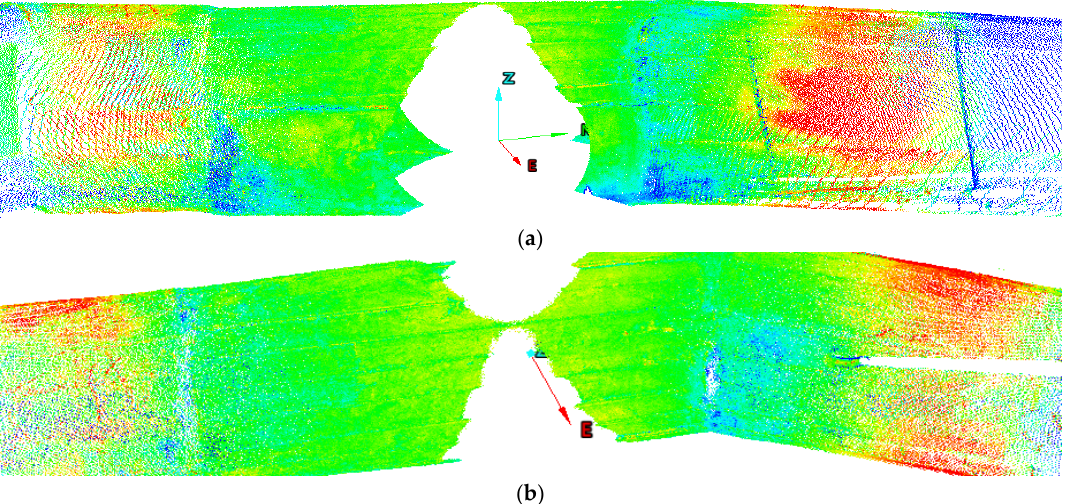
Figure 13. Missing 3D laser point cloud data. ( a ) Side view; ( b ) Front view.